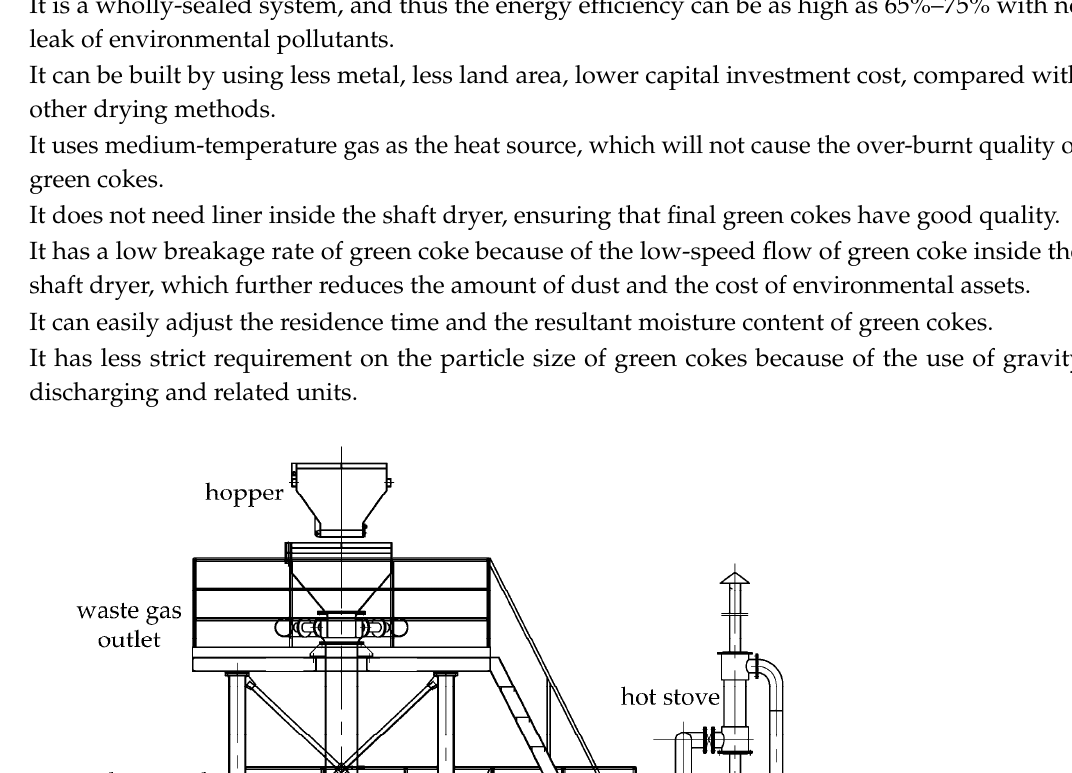
Table 2. Particle size distribution of green cokes. Test No.